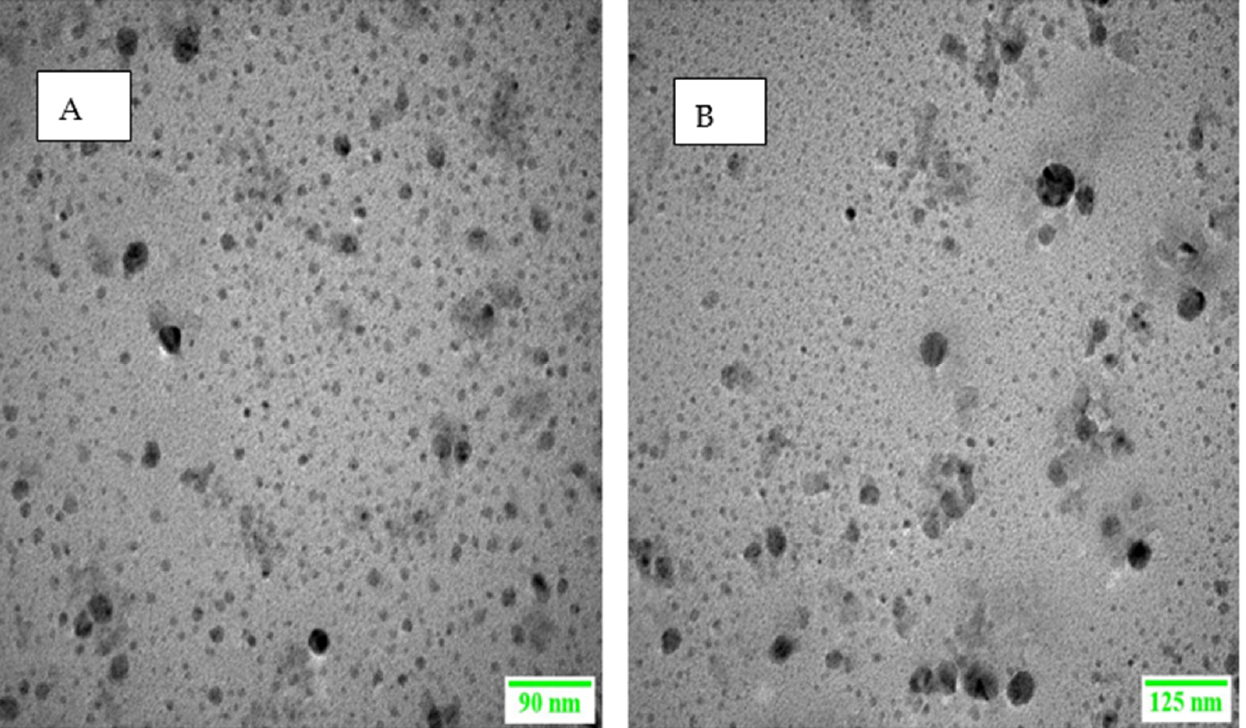
Figure 2. TEM images of ( A ) LRX-loaded NE ( B ) C-LRX-loaded NE.